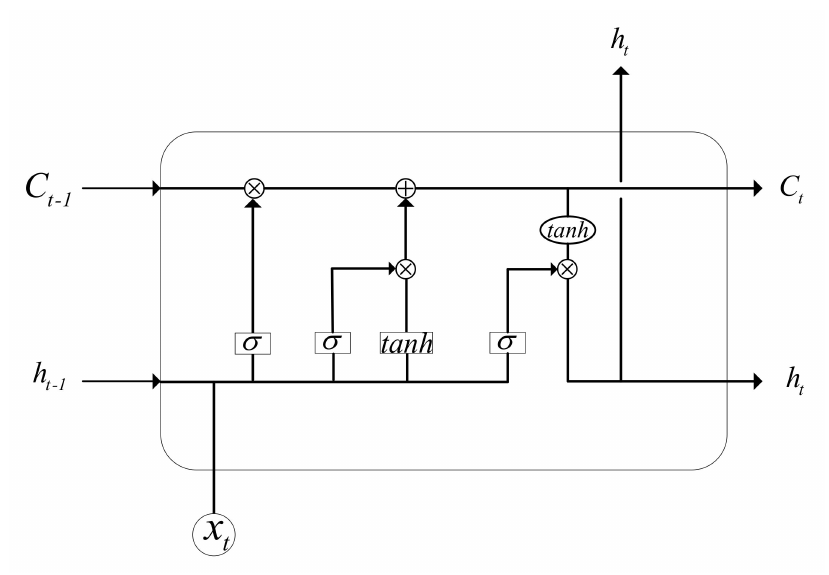
Figure 1. The basic LSTM